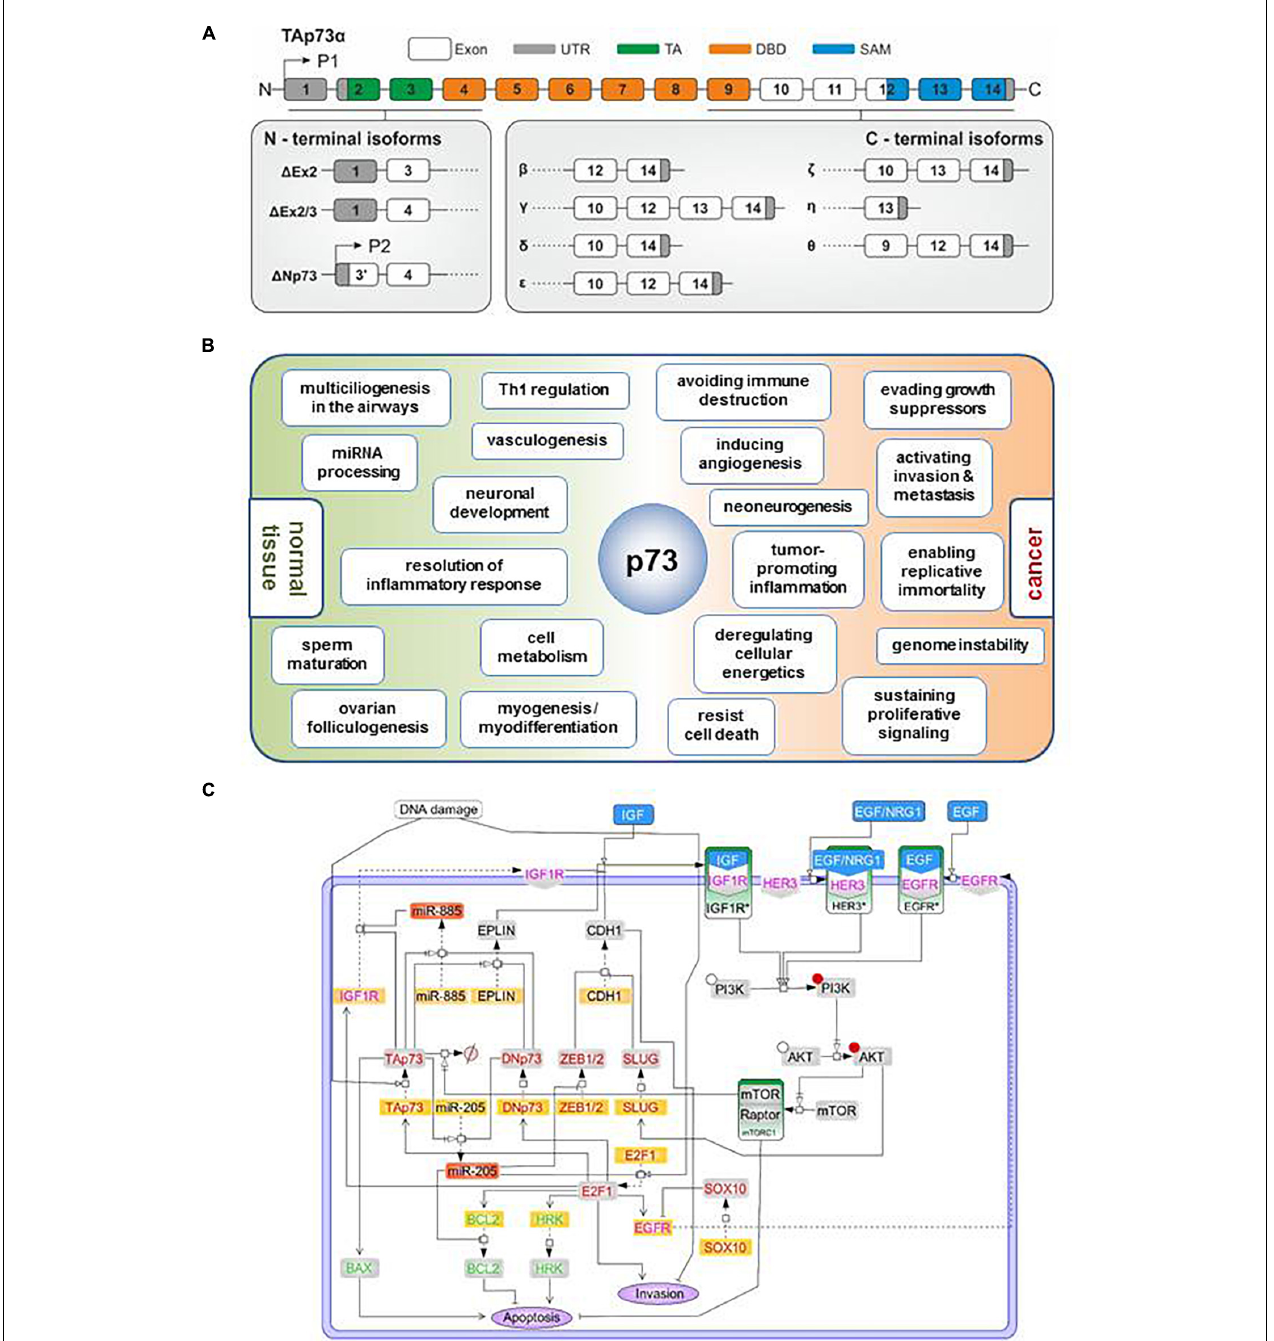
FIGURE 1 | TP73 synthesizes a large number of isoforms contributing to its multifunctionality both in physiological and cancer-related processes. (A) Diagram depicting synthesis of p73 isoforms by (i) alternative splicing in the 3 (cid:48) end, putting forth several C-terminal splice variants; or (ii) the use of an extrinsic (P1) and alternative intrinsic promoter (P2) in the 5 (cid:48) end, and (iii) alternative splicing in the 5 (cid:48) end. All isoforms contain a core DNA-binding domain. Different combinations of the N-terminal head with the C-terminal tail give rise to functionally distinct isoforms. TA, transactivation domain; DBD, DNA-binding domain; SAM, sterile alpha motif. (B) Overview of the documented and predicted roles of TP73 gene products in normal and cancer tissues. There are analogies in several processes regulated by TP73 in the physiological and cancer context (terms straddling around the p73 node in the scheme) which might represent the aberrant function of p73 regulatory networks of embryonic development, differentiation, and tissue homeostasis within the tumor context. (C) Regulatory map of the TAp73/DNp73-controlled pathways depicting their interception with major cascades of extracellular signaling. The model was constructed using SBGN-compliant software Cell Designer. Yellow boxes: RNA; gray boxes: protein; red boxes: mature microRNAs; green boxes: activated signaling complexes; blue boxes: receptor ligands; red font: transcription factors, green font: apoptosis related proteins; magenta font: growth factors. Phosphorylated proteins are marked with a red circle.